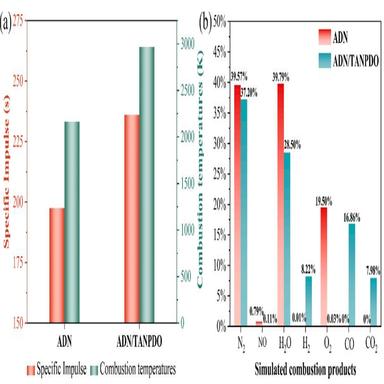
The energy performance of ADN and ADN/TANPDO supramolecular: (a) The Isp and combustion temperature of ADN and ADN/TANPDO supramolecular crystal. (b) The simulated combustion products of ADN and ADN/TANPDO supramolecular.